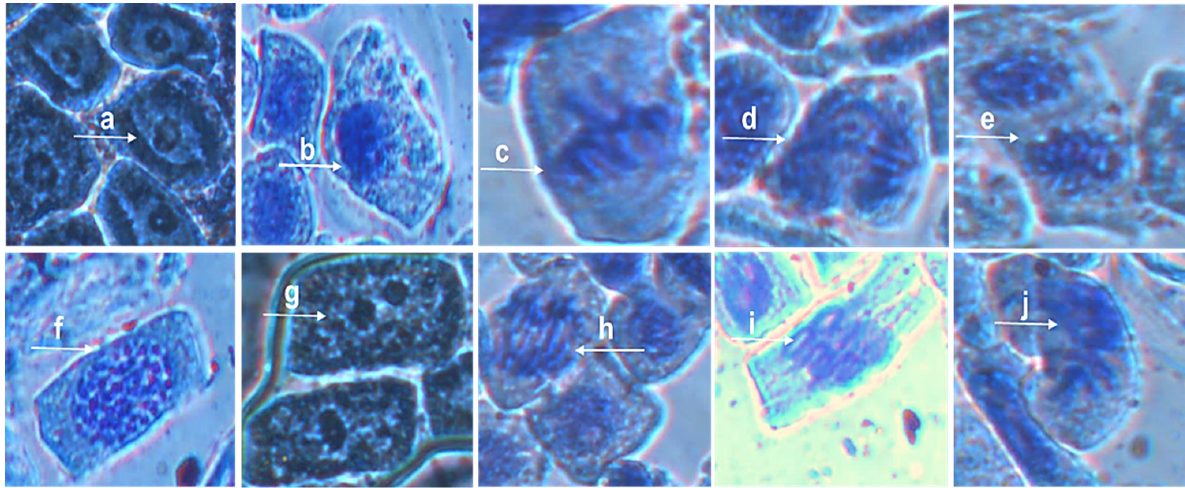
Figure 7. Genotoxicity studies on Allium cepa root cells. Control cells in interphase, prophase, metaphase, anaphase, and telophase are labeled ( a – e) , respectively. ( f ) = vagrant chromatin fragment in nucleus, ( g ) = binuclei, ( h ) =Anaphase bridge with lag, ( i ) = sticky chromosome, ( j ) =